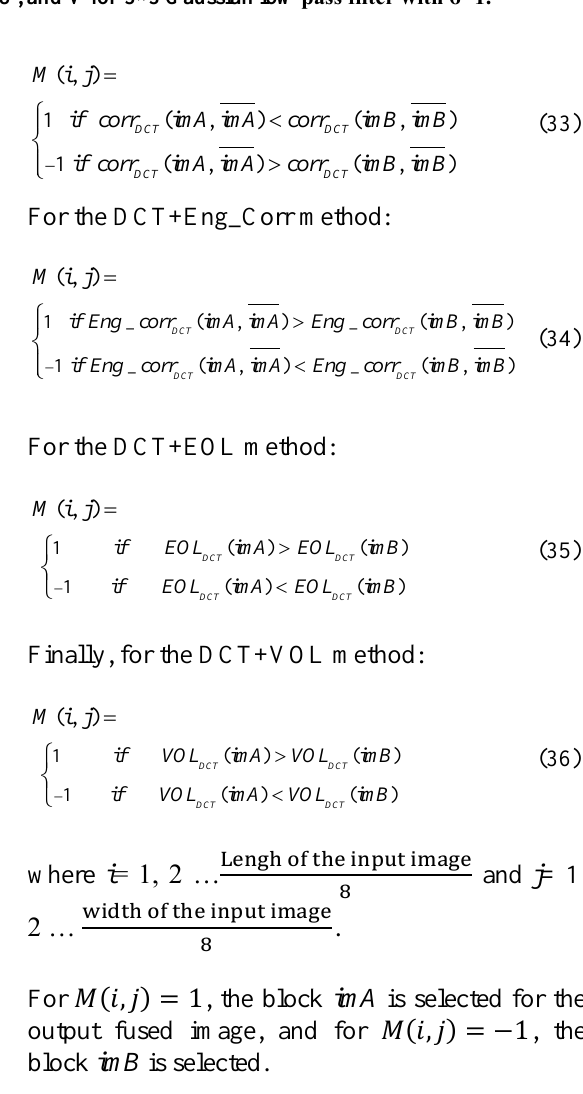
Figure 3. DCT representation of matrices LU, Q, T, S, U, and V for 3×3 Gaussian low-pass filter with